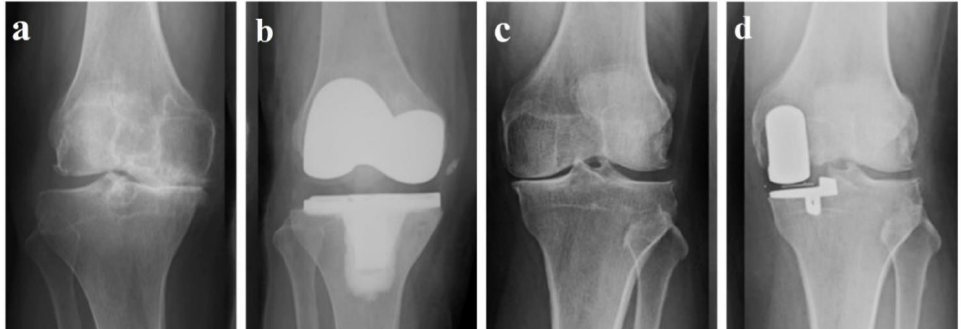
Figure 1. Pre- and Post-operative images. ( a ) Preoperative antero-posterior view X-ray image of the right knee of a patient with medial compartment osteoarthritis who was planned for Total Knee Arthroplasty (TKA). ( b ) Post-TKA X-ray image of the same patient. ( c ) Preoperative antero-posterior view X-ray image of the left knee of a patient with medial compartment osteoarthritis who was planned for Unicompartmental Knee Arthroplasty (UKA). ( d ) Post-UKA X-ray image of the same